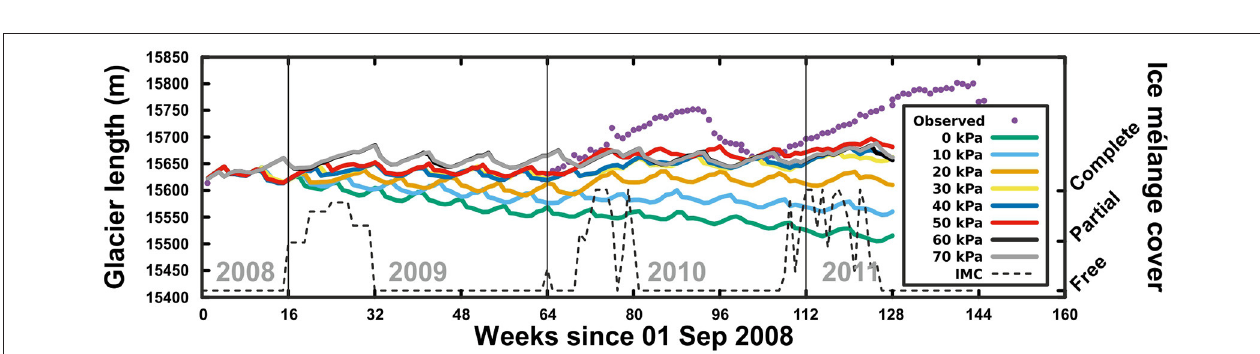
FIGURE 5 | Modeled flowline glacier length for different constant crevasse water depths, with an ice mélange backstress of 50 kPa. Magenta dots represent the observed glacier lengths. Week means here 1/48 of a year.